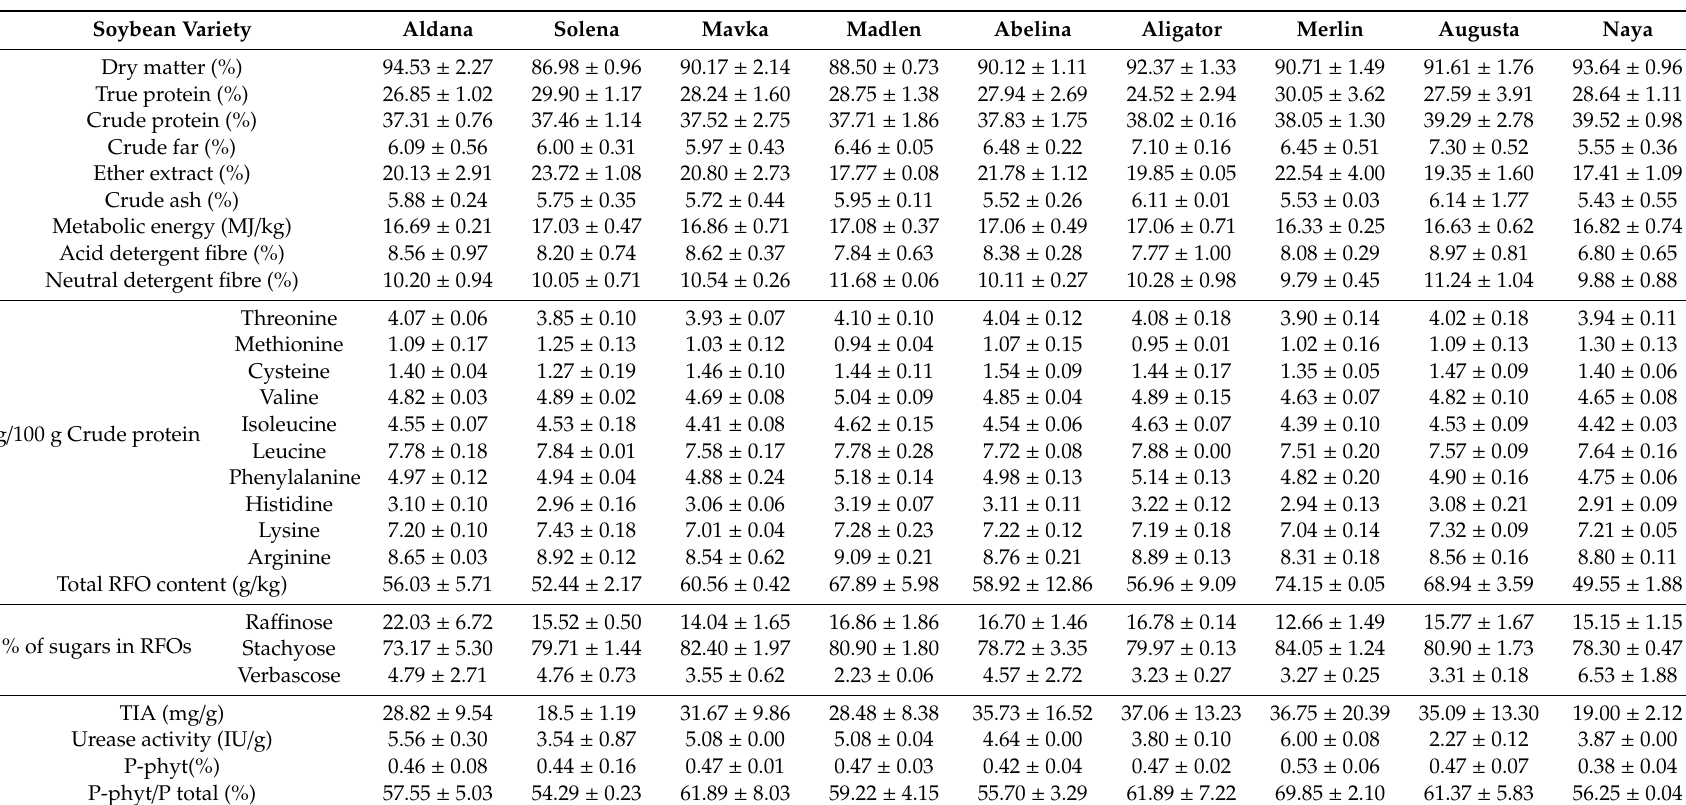
Table 3. The average chemical composition of di ff erent soybean seeds varieties (% in DM), with a medium level of protein (37 to 40% in DM). Soybean